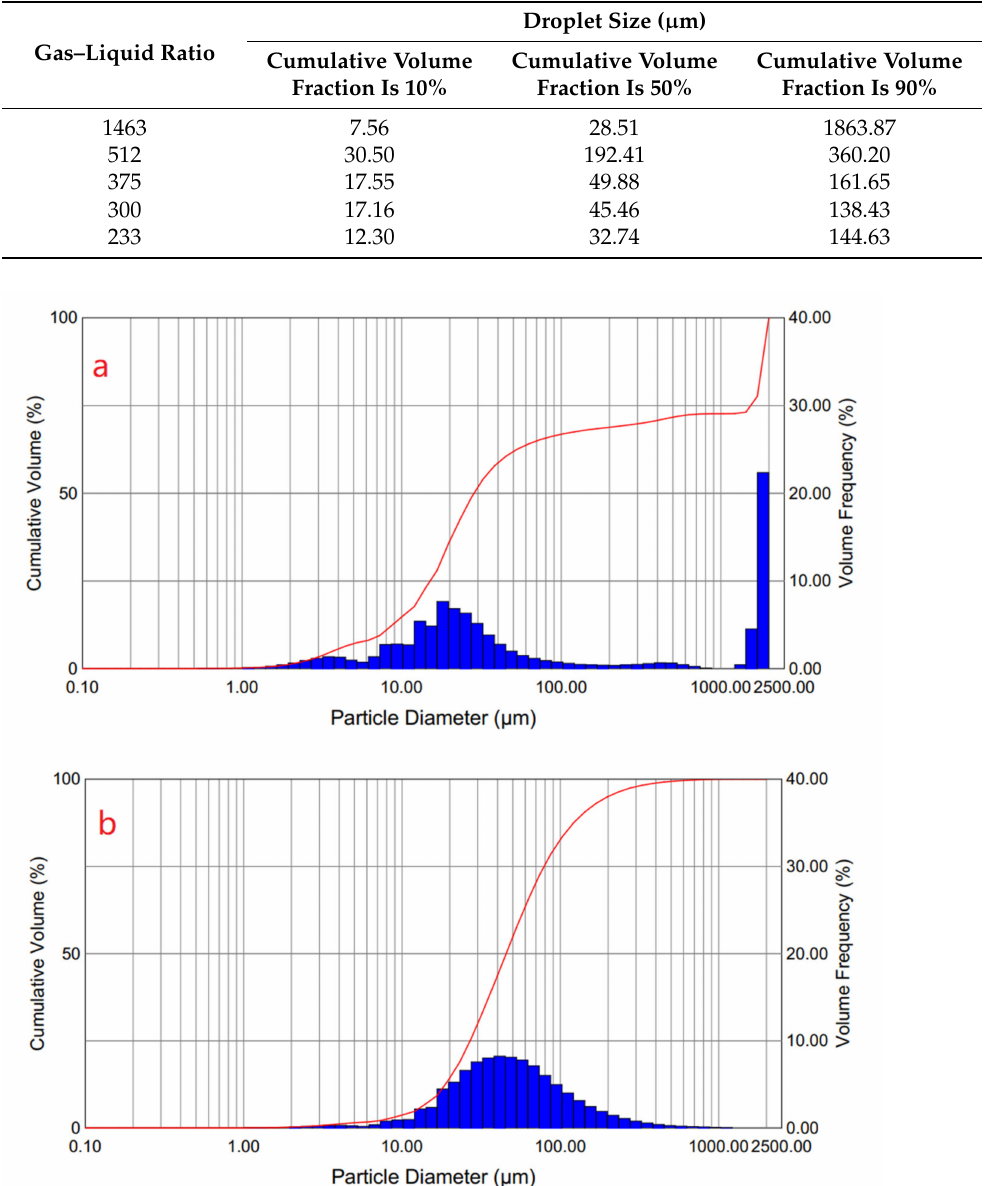
Table 1. Droplet size distribution under five different gas–liquid ratios.